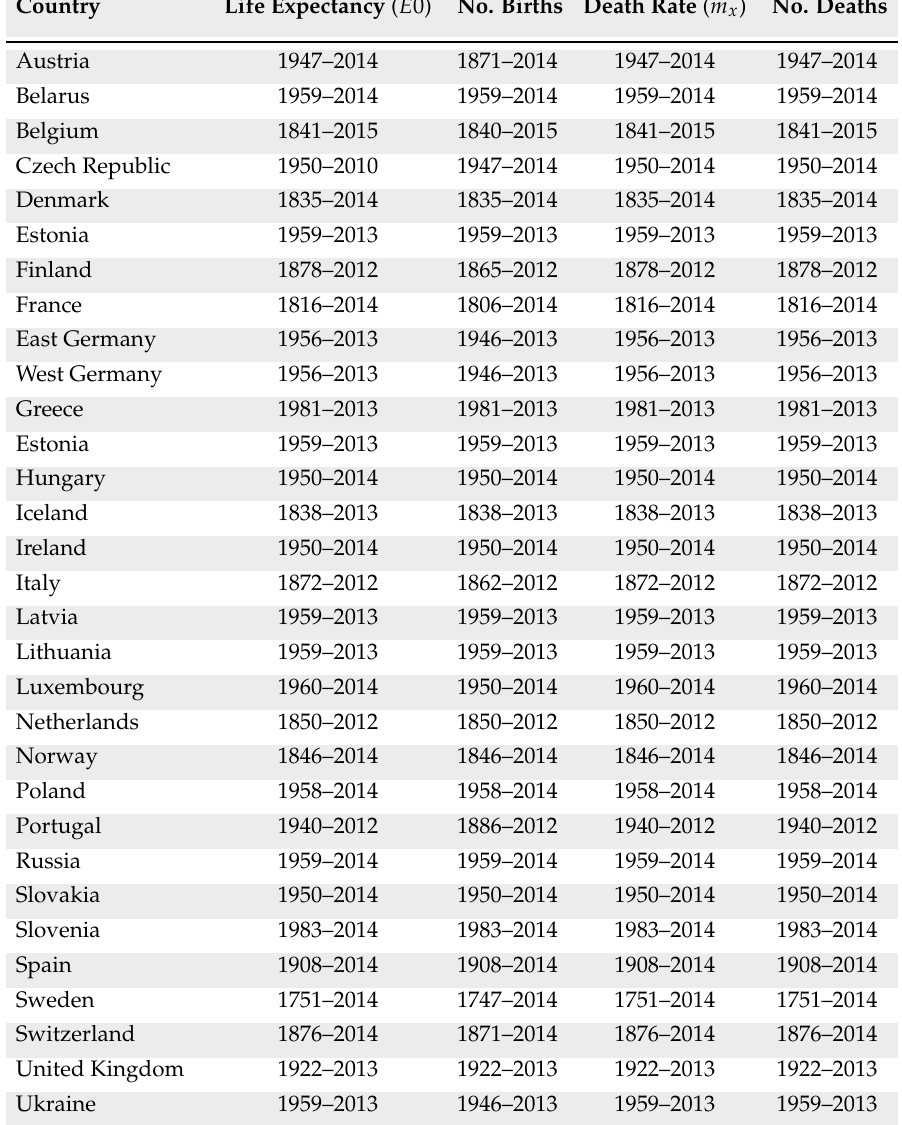
Table 1. The availability of the demographic data per country (Human Mortality Database). Country Life Expectancy ( E 0) No. Births Death Rate ( m x ) No.